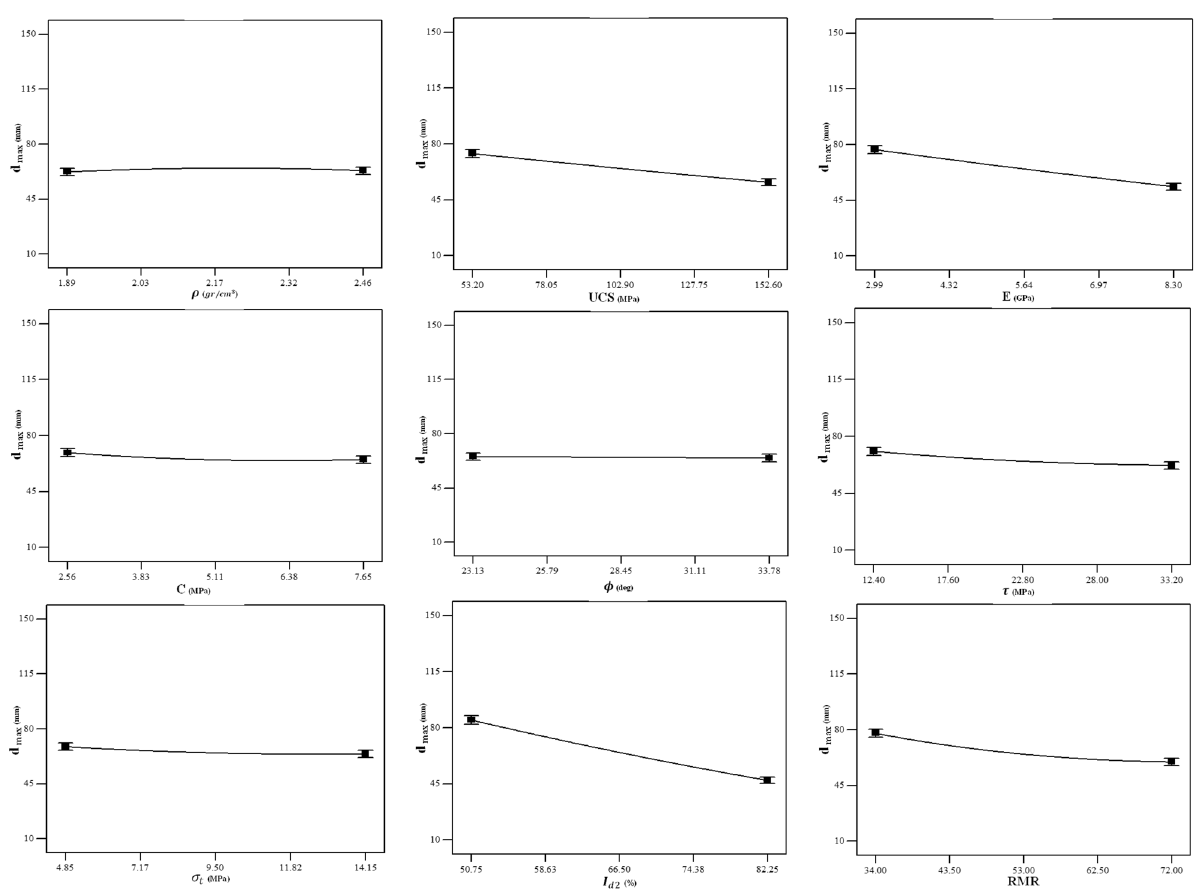
Figure 12. Influences of the input variables on the d max